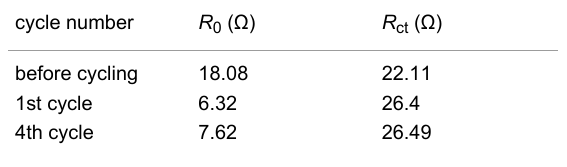
Table 1: Impedance parameters of the S-3D-RGO@MWCNT cathode. cycle number R 0 ( Ω ) before